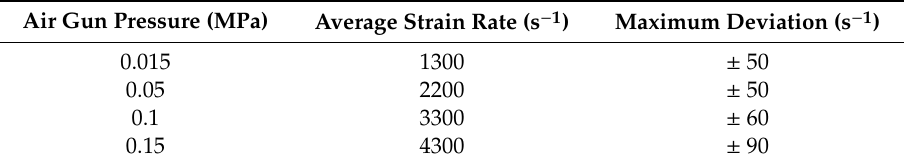
Table 3. Loading pressures and strain rates of specimens.